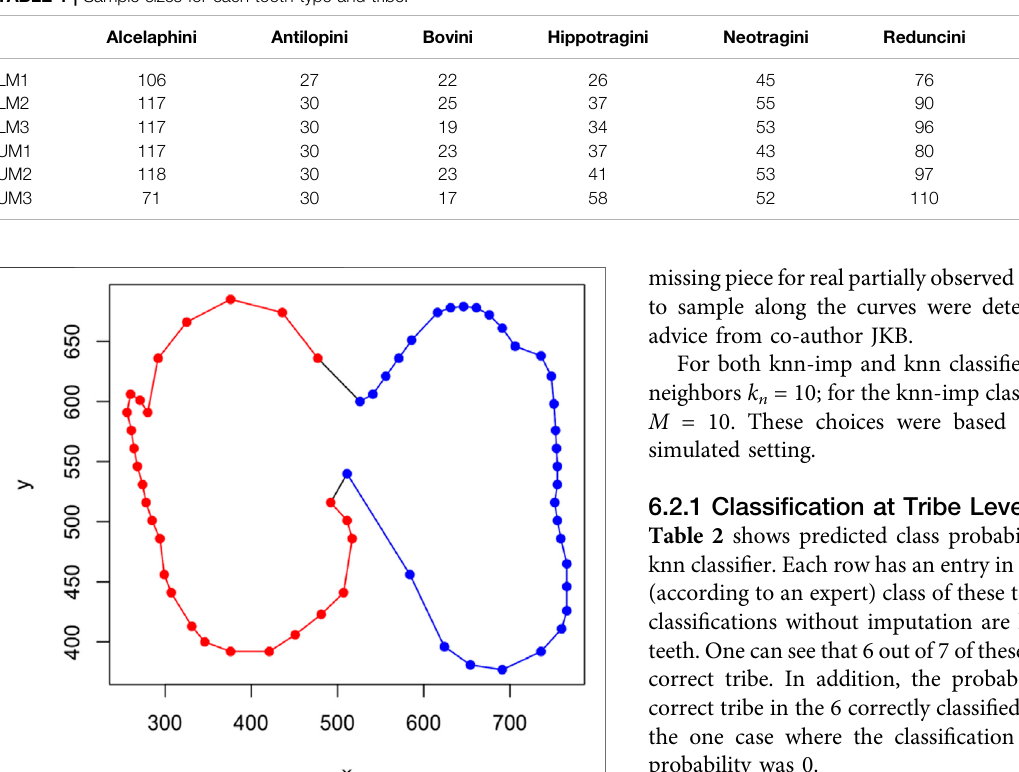
TABLE 1 | Sample sizes for each tooth type and tribe.